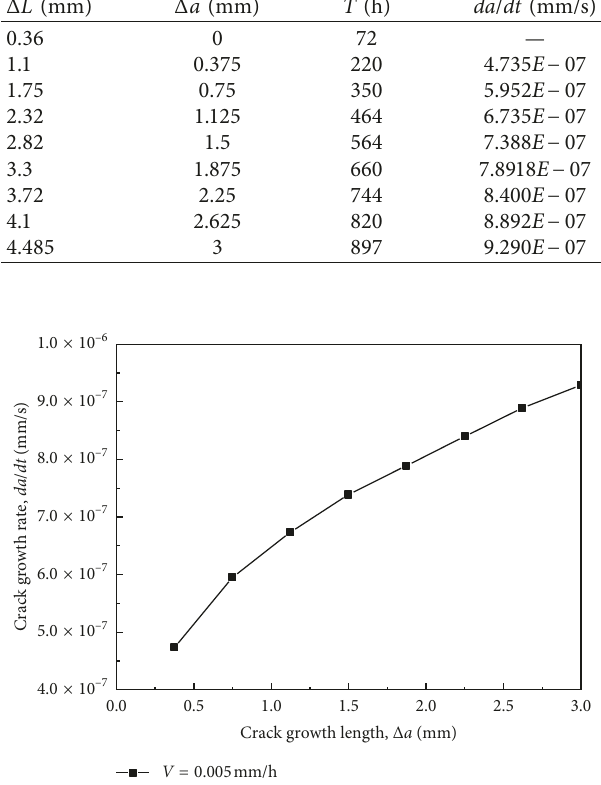
Figure 8: The relationship between crack growth rate and crack growth length.